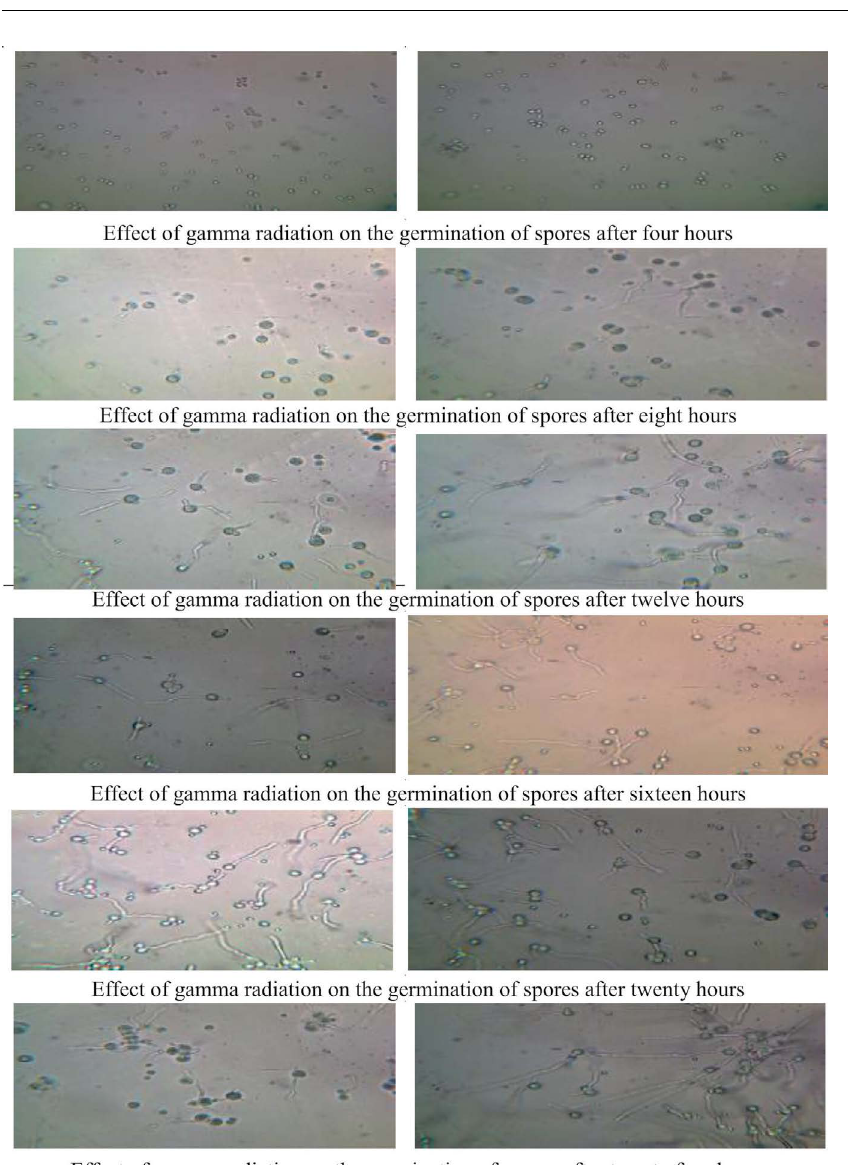
Fig. 2. Germination of Penicillium chrysogenum spores either gamma radiated at a dose of 200 Gy or